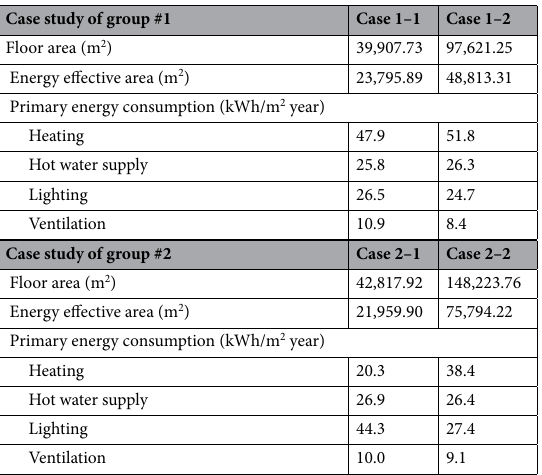
Table 4. Energy use information of target apartments for case study. 1. Group #1: Heating (city gas), Hot water supply (city gas), Lighting and Ventilation (electricity). 2. Group #2: Heating (district heating), Hot water supply (district heating), Lighting and Ventilation